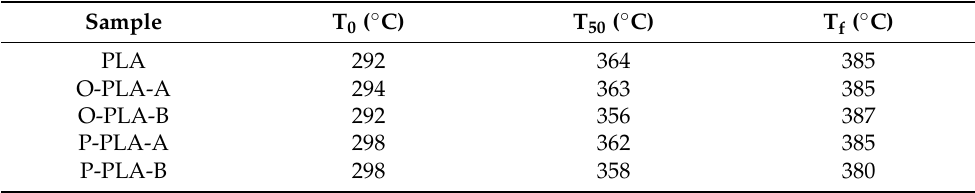
Figure 5. DSC thermograms for neat and functionalized PLA flat tapes obtained by reactive extrusion. Table 7. Main thermal parameters of neat and functionalized PLA flat tapes by reactive extrusion obtained by TGA